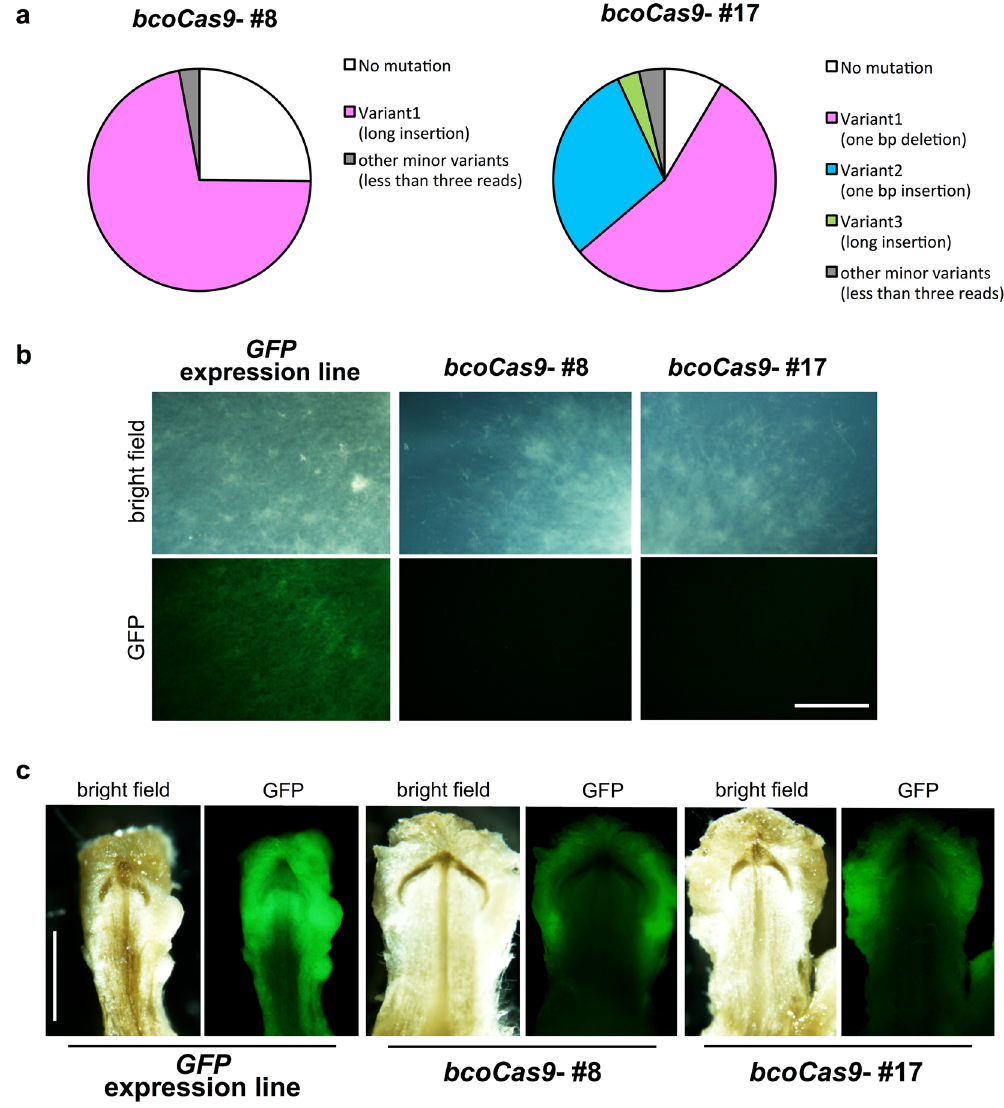
Figure 4. Isolation of genome-edited mushrooms. ( a ) Analyses of mosaic rates in the C. cinerea CRISPR/Cas9 mutant lines. Ratios of reads with mutation to total reads are described for each variant. Total read counts were 373 reads for #8 and 621 reads for #17, respectively. ( b,c ) GFP loss-of-function in the C. cinerea CRISPR/Cas9 mutants. GFP fluorescence was diminished in vegetative mycelium ( b ), and fruiting body primordia ( c ) in the transformants. Bars = 1